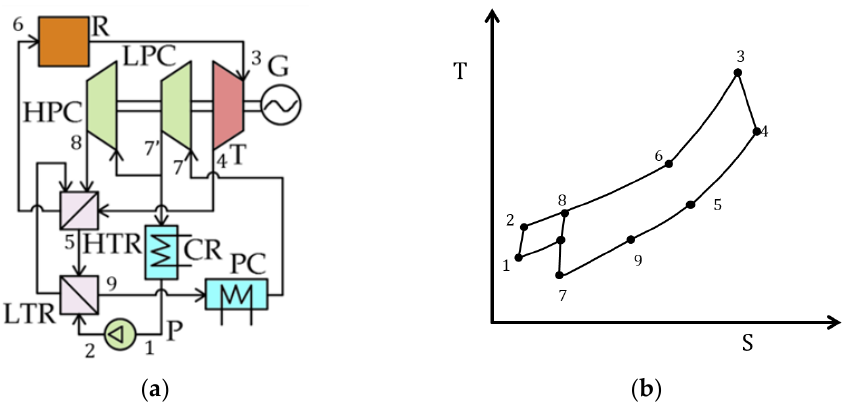
Figure 5. Supercritical CO 2 Brayton cycle with partial cooling: ( a ) schematic diagram; ( b ) T – S diagram [12]. R — reactor; T – turbine; G — generator; HTR — high-temperature regenerative heat exchanger; LTR — low-temperature regenerative heat exchanger; PC — precooler; CR — gas cooler; LPC — low-pressure compressor; HPC — high-pressure compressor.